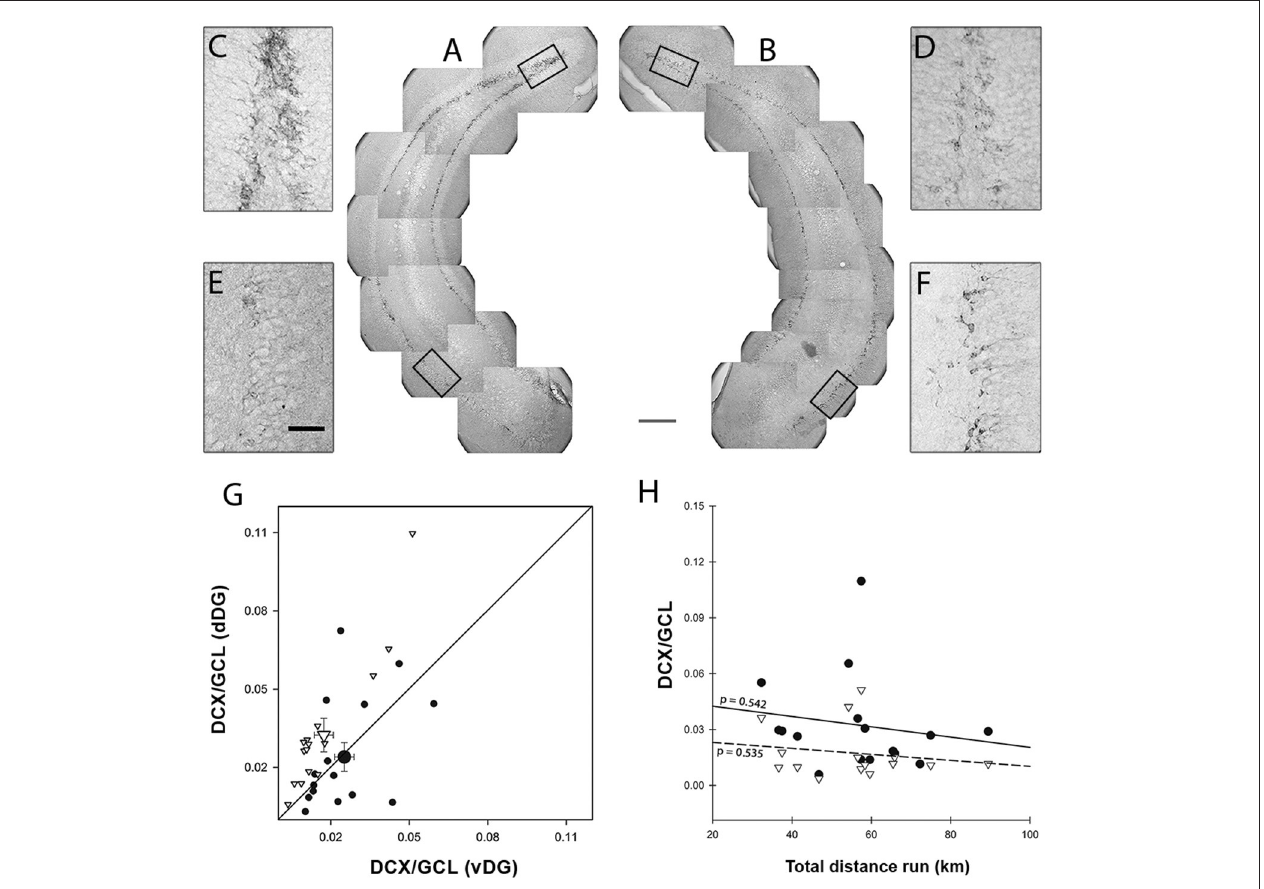
FIGURE 3 | DCX Morphological analysis. Image montage of representative dentate gyrus (DG) coronal sections of Enriched (A) and Control (B) animals (14-week-old CD-1 female mice) showing different amounts of DCX staining in dorsal and ventral DG (dDG and vDG, respectively). The inset magnification shows that the amount of staining in E-dDG (C) is higher than in C-dDG (D) while conversely it is lower in E-vDG (E) compared to C-vDG (F) . Scale bars : gray = 225 µ m, black = 50 µ m. Panel (G) shows the amount of dorsal DCX staining plotted against the amount of ventral DCX staining. In the Enriched animals, the proportion of dorsal DCX + pixels is higher than ventral ones [points above the diagonal; EdDG vs. EvDG χ 2 (1) = 14.835 p < 0.001], while in the Control animals, dorsal and ventral are equivalent. Black dots = Control, white inverted triangles = Enriched. Bigger symbols represent means with bi-dimensional bars representing SEM. (H) The effect of distance run, plotted against DCX/GCL showed no significant effects or interactions. Black dots = dDG, white inverted triangles = vDG, continuous line = dDG regression line, dashed line = vDG regression